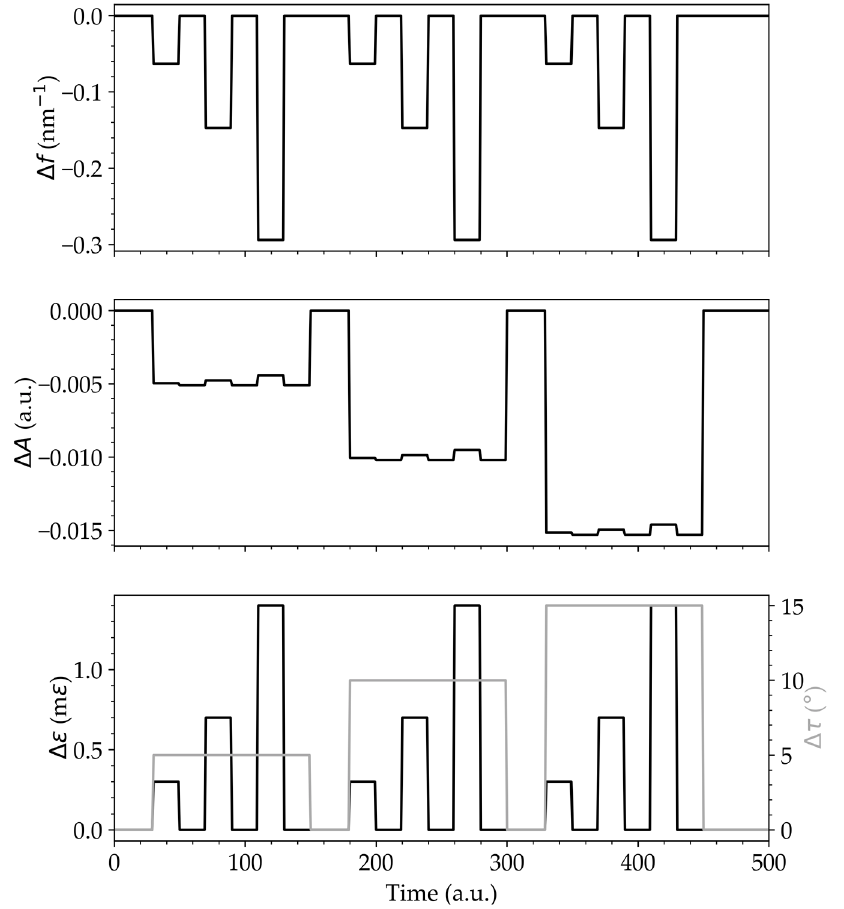
Figure 6. Simultaneous strain and torsion measurements by applying Equation